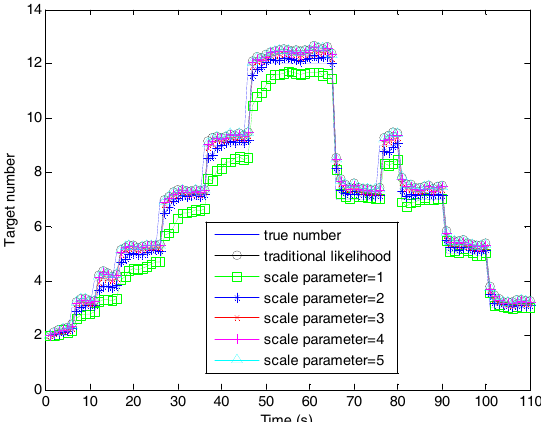
Figure 4. Target number estimation of the sequential Monte Carlo (SMC) adaptive target birth intensity CBMeMBer filter and the fast SMC adaptive target birth intensity CBMeMBer filter.